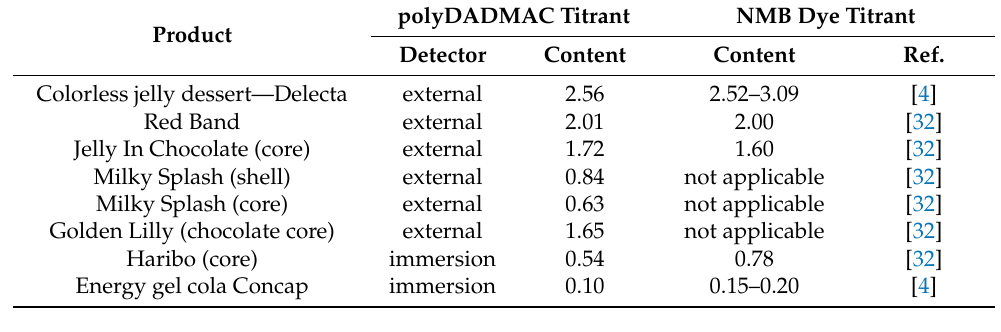
Table 1. Carrageenan content (g/100 g) in food products determined with the external light transmit- tance sensor and the immersion optical probe.